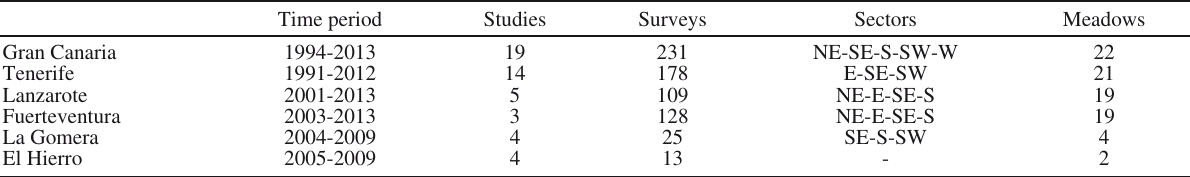
Table 1. – Summary of data compilation for each